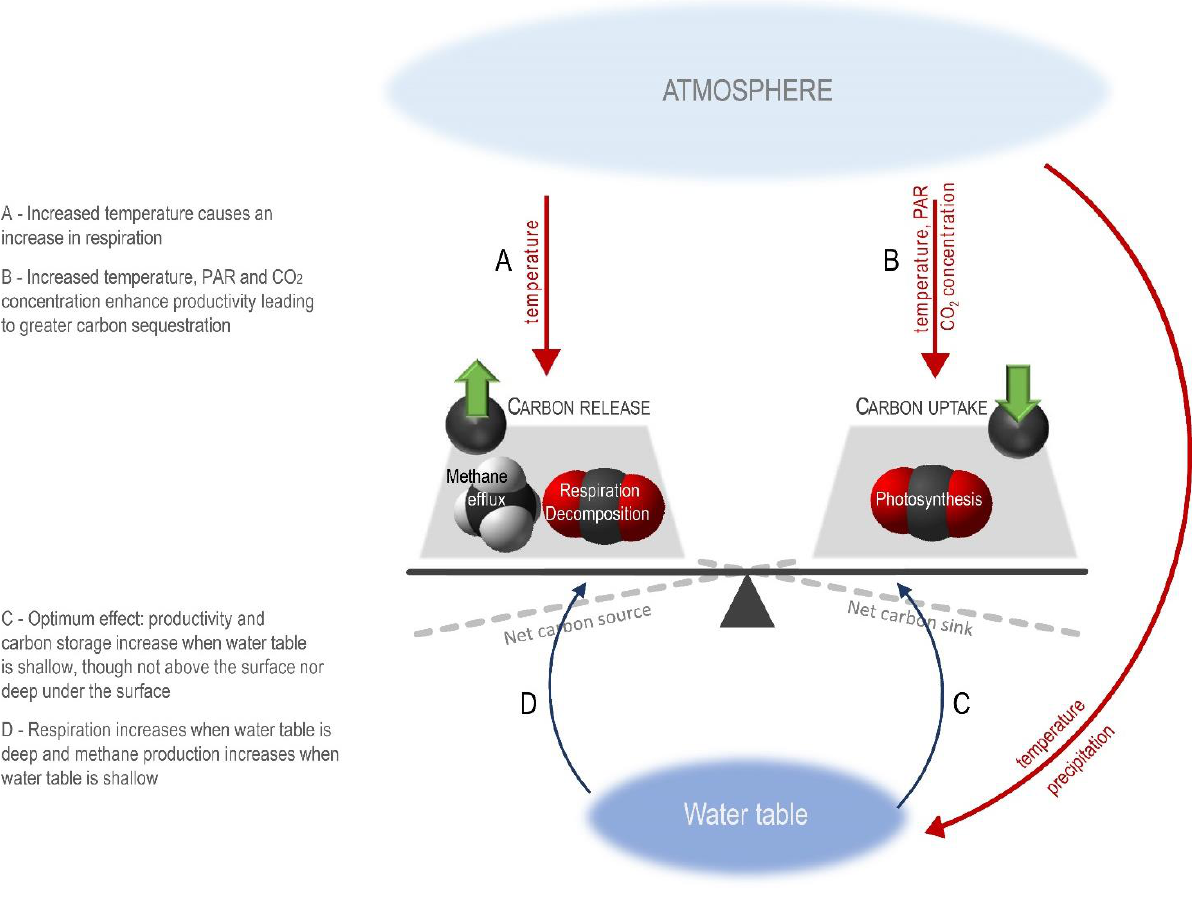
Figure 1. Dynamics and feedbacks of the carbon balance in